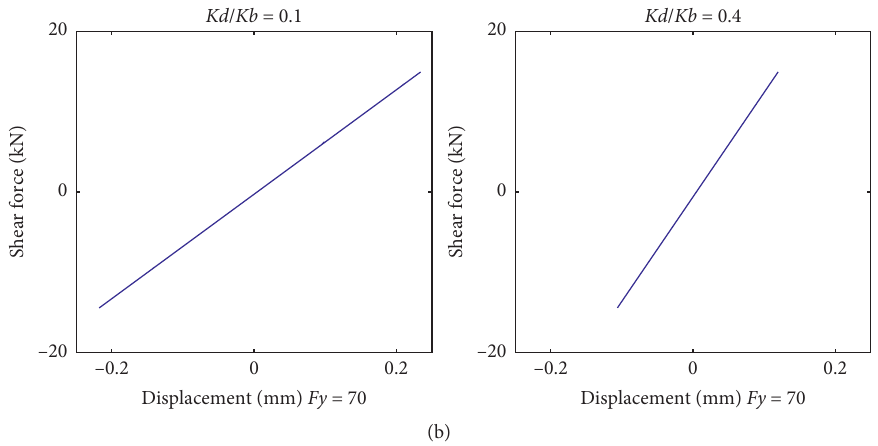
Figure 23: Hysteresis in shear direction ( Fy � 30kN/ Fy �